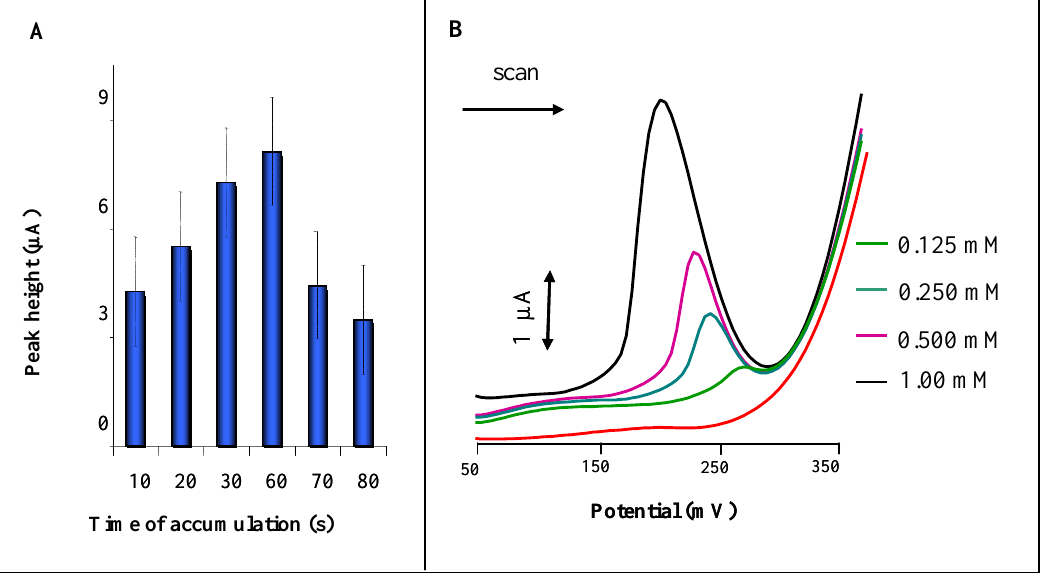
Figure 2. Electrochemical analysis of chloride ions using a CPE modified with solid silver(I) nitrate. ( A ) Dependence of signal height (100 µ M NaCl) on accumulation time. Accumulation potential 250 mV. ( B ) DP voltammograms of NaCl (0.125, 0.250, 0.500 and 1.00